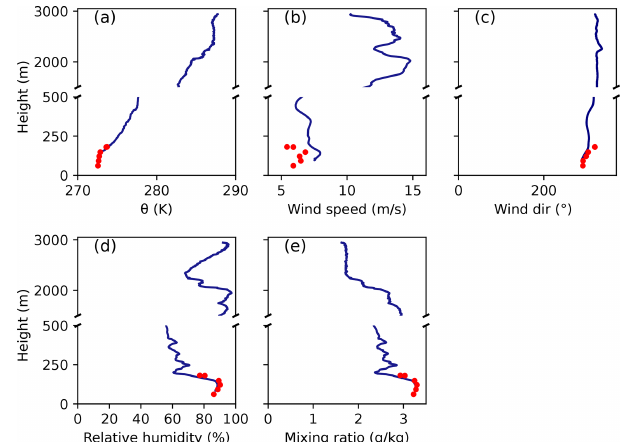
Figure 12. Results for 20 June 2017 obtained from a descent of Polar 5 at the location of the northernmost horizontal legs (see Fig. 11).